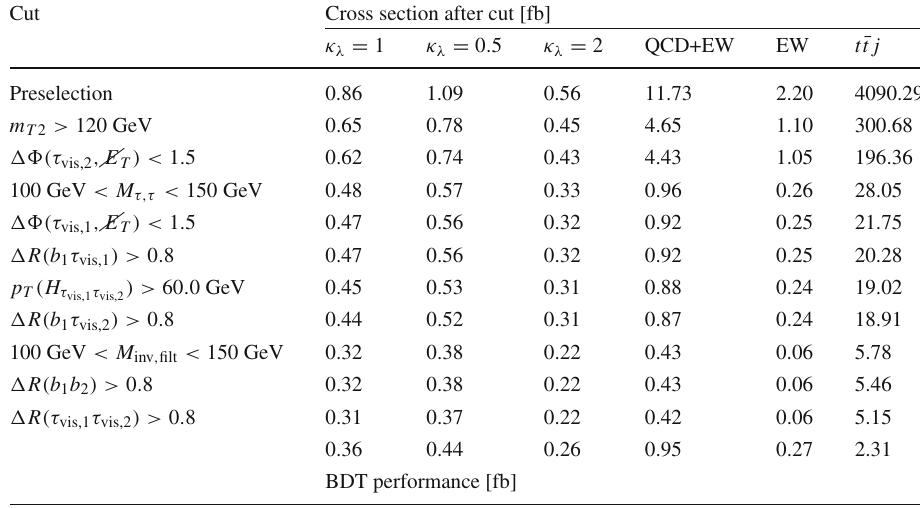
Table 7 Observables included to the boosted decision tree for the fully-resolved 4 b -jet analysis of pp → hhj , Sect. 3